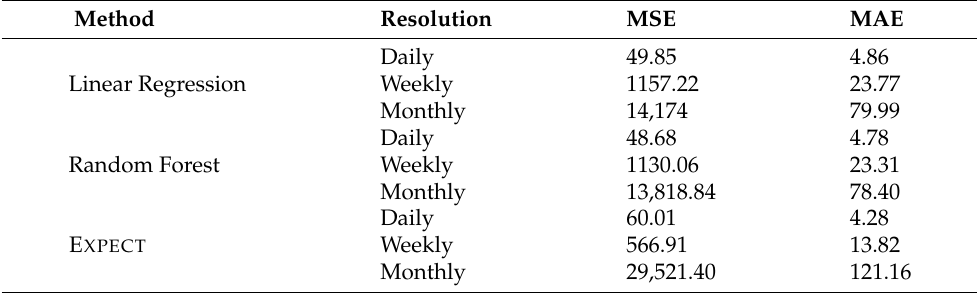
Table 4. Performance evaluation with RDC and DDC.